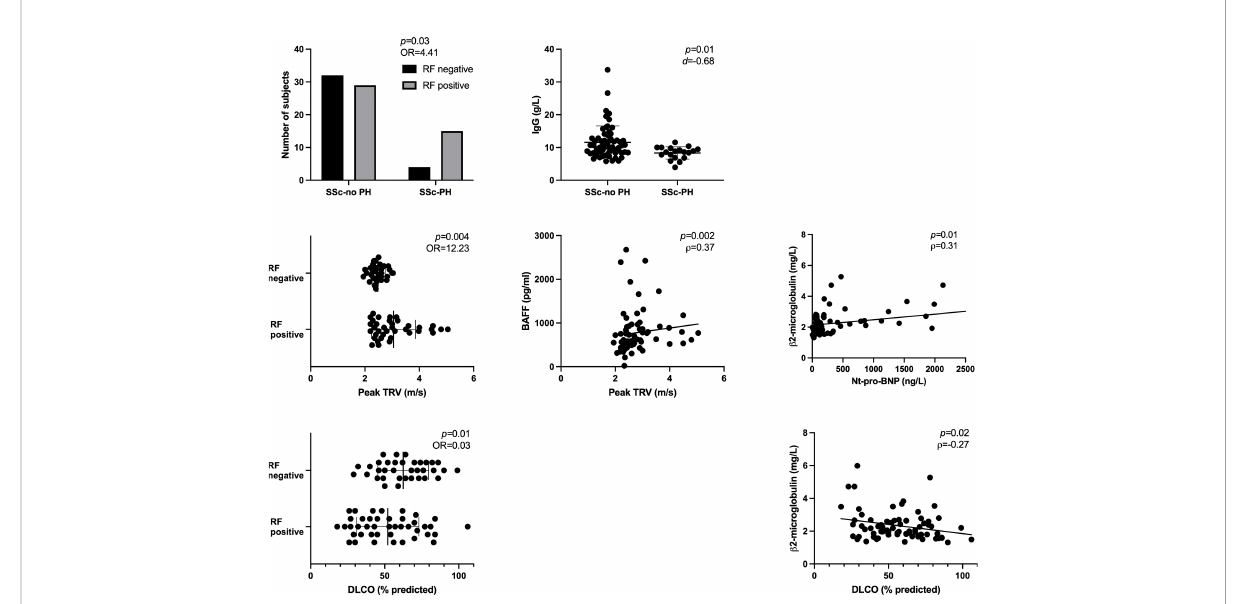
FIGURE 2 Signi fi cant associations between serum levels of soluble markers of B cell activation and SSc characteristics related to PH, assessed among the 80 SSc patients from the discovery cohort. BAFF, B-cell-activating factor; DLCO, diffusing capacity of the lung for carbon monoxide; Ig, immunoglobulin; Nt-pro-BNP, N-terminal prohormone of brain natriuretic peptide; OR, odds ratio; PH, pulmonary hypertension; RF, rheumatoid factor; SSc, systemic sclerosis; TRV, tricuspid regurgitation velocity. Error bars display means and standard deviations. p -values are adjusted for age, gender and immunosuppressive